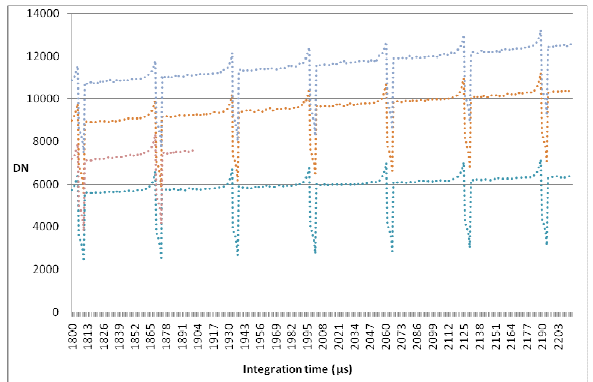
Figure 5. DN values of one sample obtained at different integration times. Four measurements at four different scene illuminations